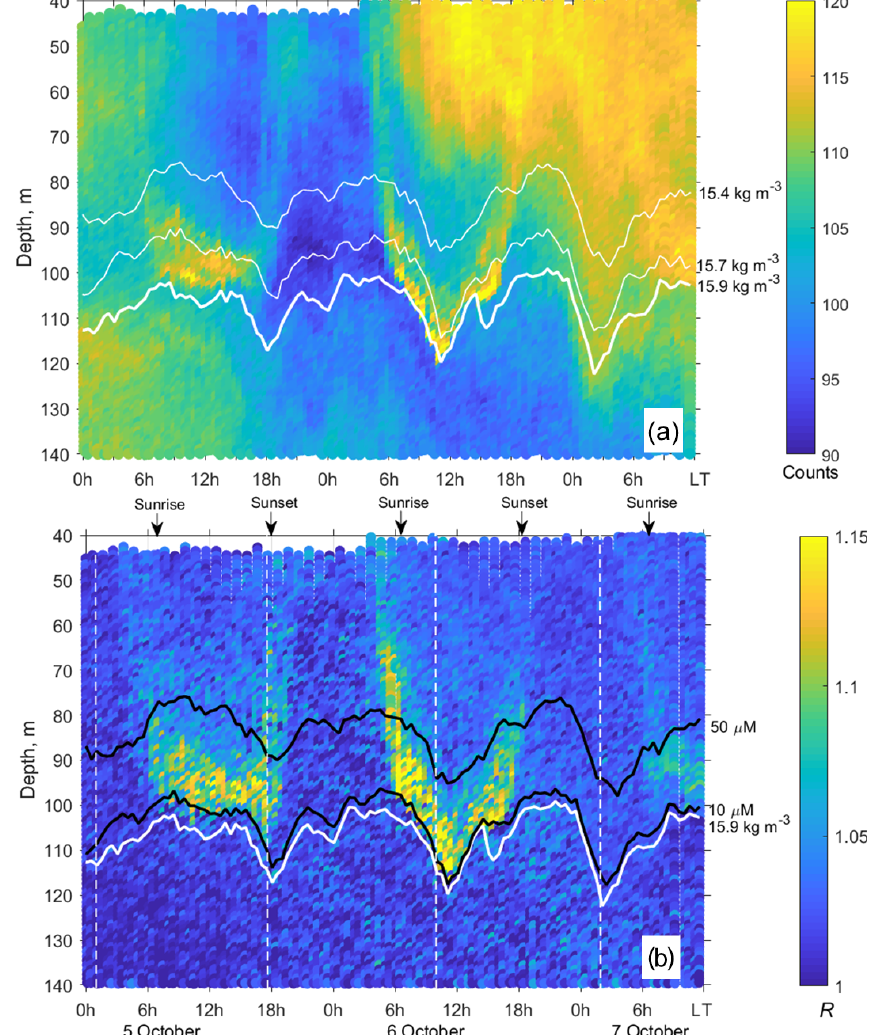
Figure 5. (a) The time–depth graph of the Aquadopp horizontal-beam (A 1 + A 2 )/ 2 echogram showing acoustic backscatter intensity (counts) on 5–7 October 2013. The Aqualog profiler with the Aquadopp instrument performed ascending–descending cycles every 1h. The upper, middle, and lower white lines are for isopycnals σ (cid:50) 15.4, 15.7, and 15.9, respectively. (b) Time–depth scatterplot of the Aquadopp directional acoustic backscatter ratio R = (A 1 + A 2 )/ 2 A 3 . Colored lines show [O 2 ] = 50µm (upper black line); [O 2 ] = 10µm (lower black line); and σ (cid:50) = 15.9kgm − 3 (white line), which can be taken as a proxy for the boundary of the oxygen zone in the NE Black Sea (Glazer et al., 2006, Ostrovskii and Zatsepin, 2016). Notice that due to upwelling, the oxycline was moved upward. Vertical dotted white lines indicate a 17.3h time interval, which is equal to the period of inertial oscillations at the latitude of the observation. They approximately coincide with troughs of inertial